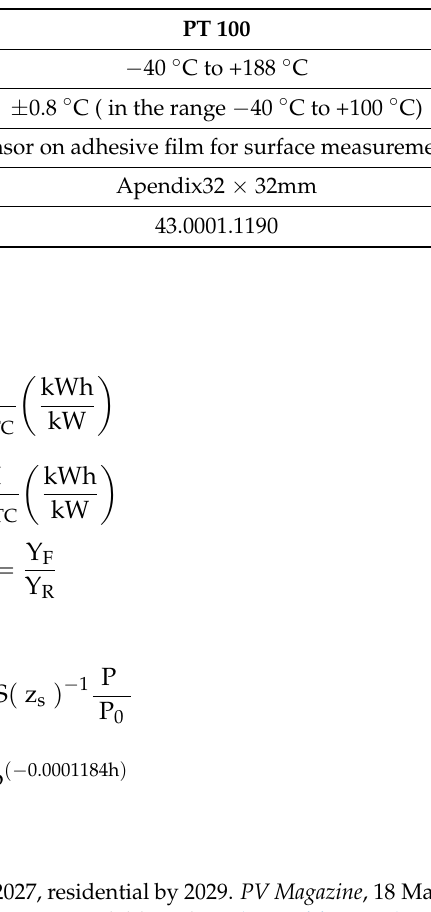
Table A4. Temperature sensor